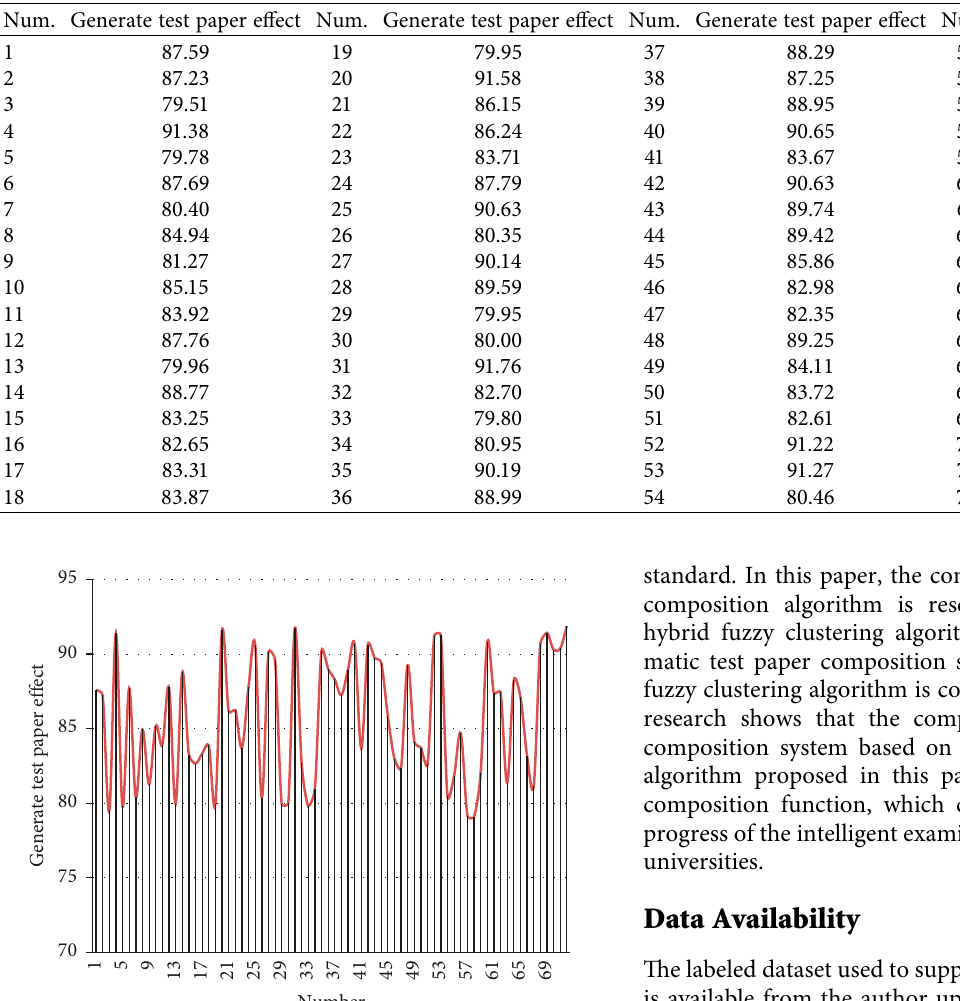
Table 1: Effect verification of computer automatic test paper composition algorithm based on hybrid fuzzy clustering algorithm.